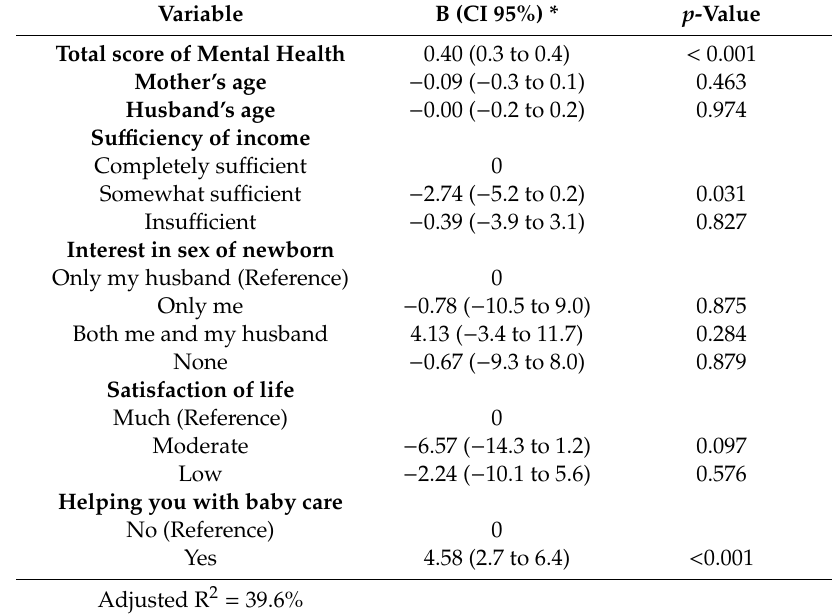
Table 4. The predictors of maternal functioning in women referred to health centers of Tabriz, Iran, 2019 ( n =